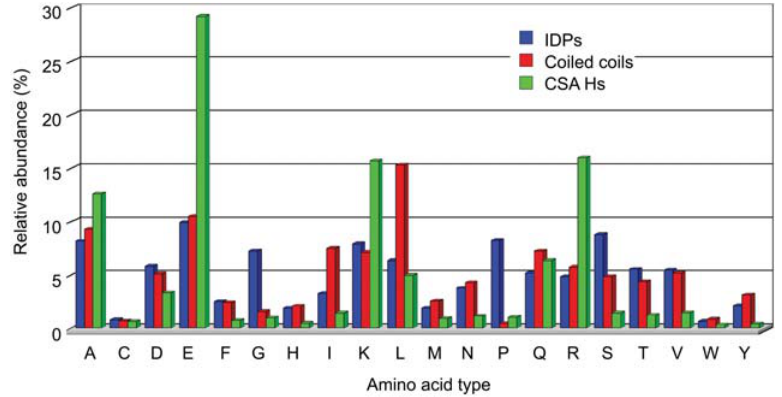
Figure 4 Amino acid abundance in IDPs, coiled coils and CSAHs. IDP sequences were taken from DisProt, coiled coils from a database generated by running SOCKET on structures listed in the PDB SELECT database, CSAHs from segments identified in Ref. (92). Data taken from Ref.